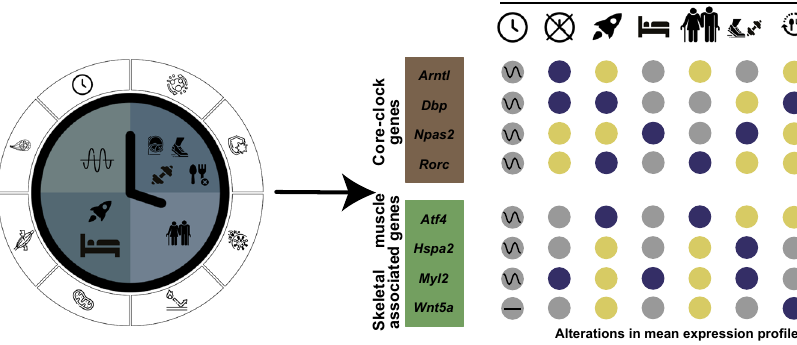
Fig. 8 Graphical representation of the study and main results. This study mainly focused on investigating molecular changes in skeletal muscle-associated and circadian rhythm-associated pathways such as metabolism, myonuclei, myogenesis (left side; symbols) in healthy skeletal muscle, and altered conditions (i.e., clock manipulation, space fl ight, bed rest, aging, exercise, fasting) from left to right order. Core- clock genes and skeletal muscle-associated genes depicted similar patterns (upregulation: yellow; downregulation: blue) in gene expression pro fi les due to space fl ight and aging on Earth (e.g. Rorc , Atf4 ; right side). While exercise or fasting conditions showed opposite gene expression patterns in the same